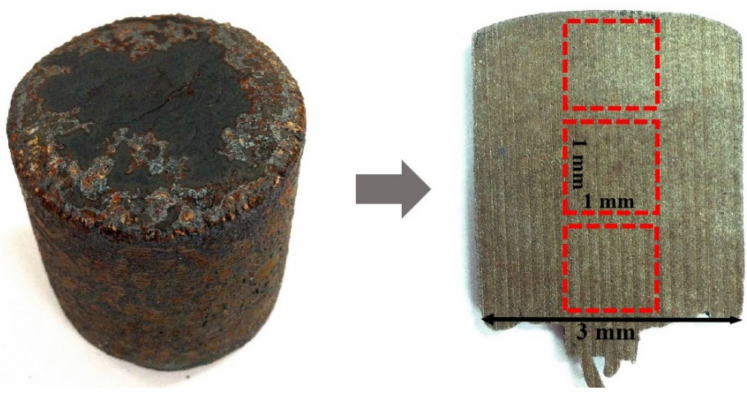
Figure 2. Schematic diagram of sampling position and size of metallographic